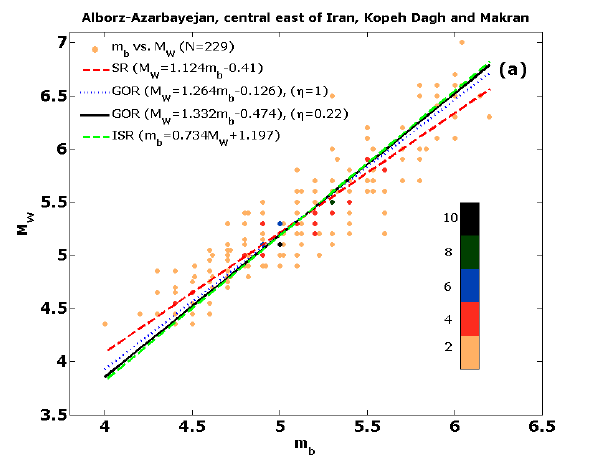
Figure 3 (clockwise from above left). m major seismotectonic provinces in Iran. SR: standard regression, ISR: inversed standard regression and GOR: general orthogonal regression.